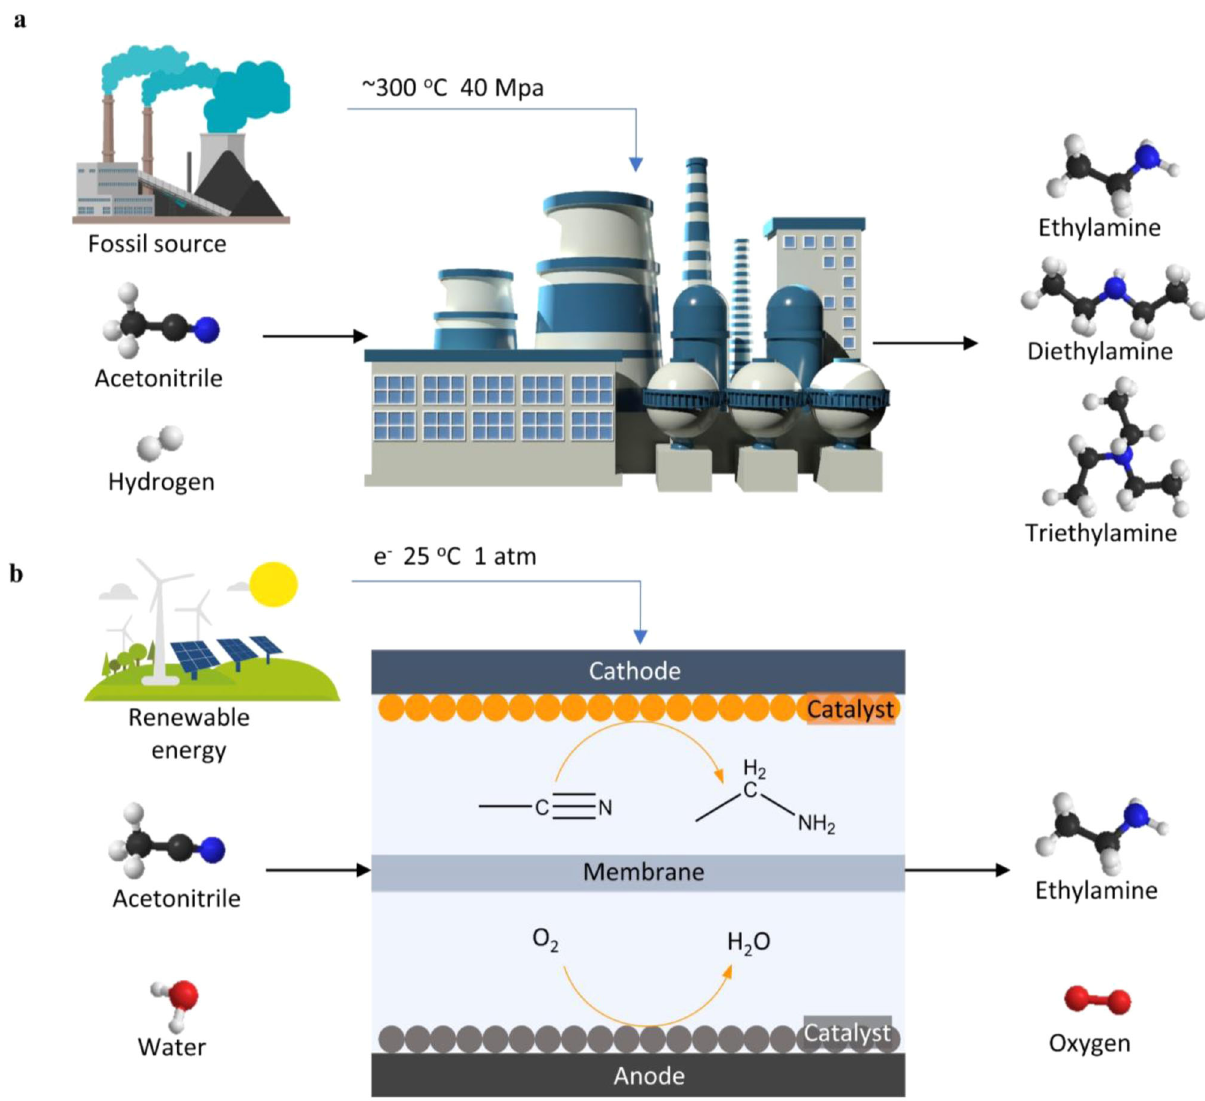
Fig. 1 Schematic comparison of acetonitrile reduction to ethylamine. a Thermal catalytic hydrogenation of acetonitrile with a relatively low selectivity towards primary amine, and ( b ) electroreduction of acetonitrile with a >90% selectivity towards primary